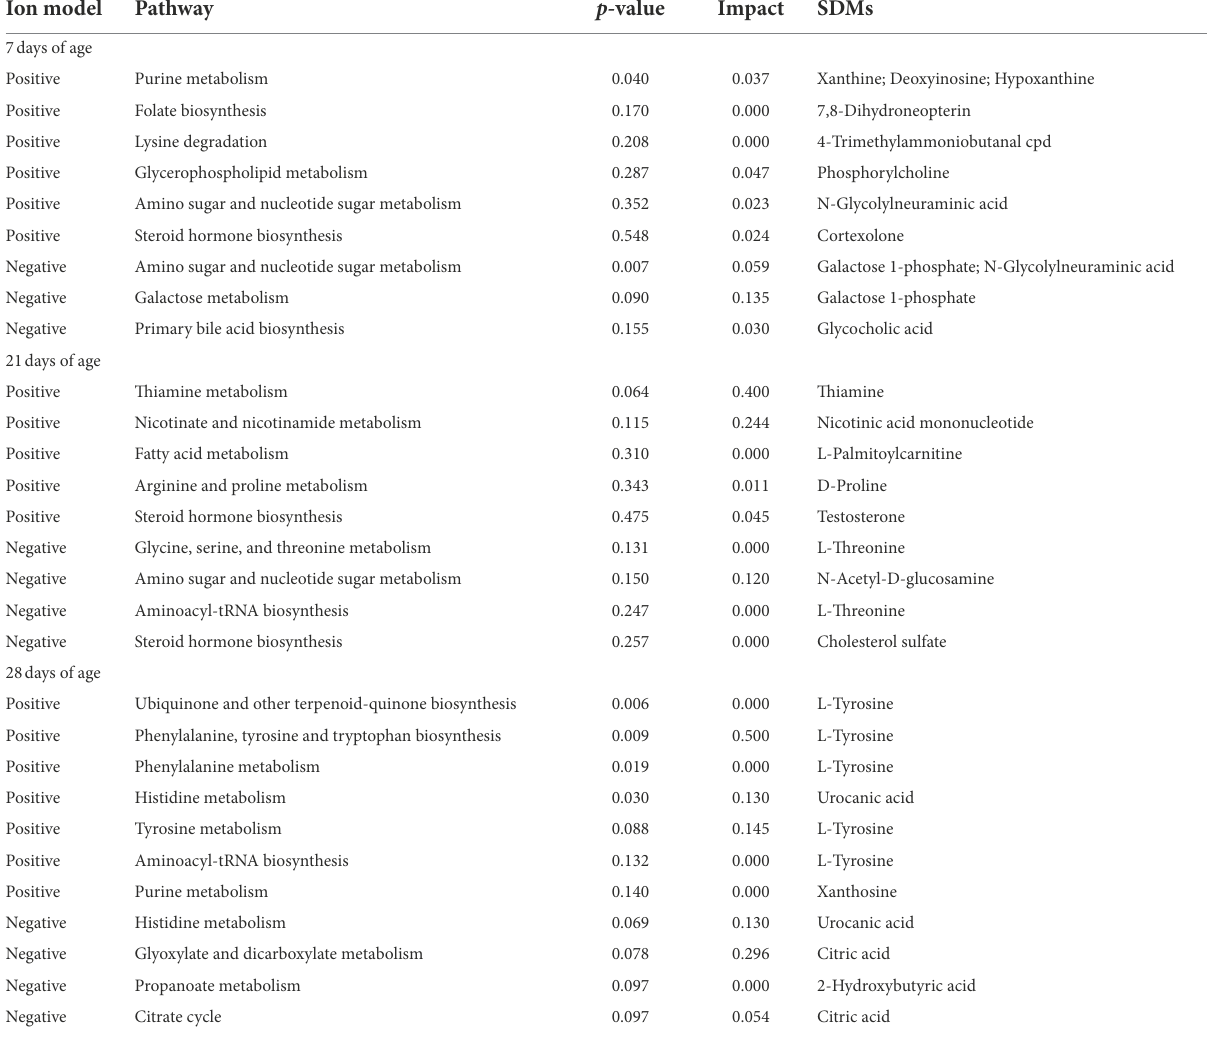
TABLE 1 Metabolite pathways and significantly different metabolites (SDMs) markers between the IUGR and NBW piglets in the positive and negative ion models at 7, 21, and 28 days of